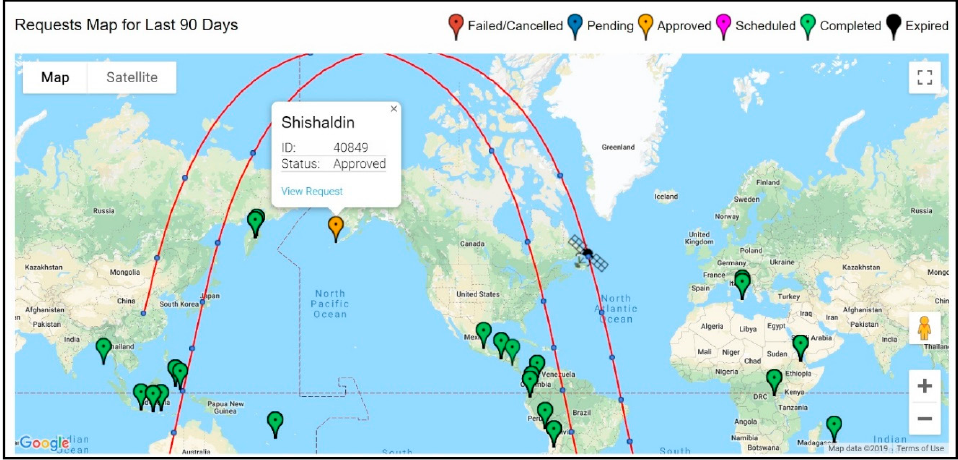
Figure 3. The ASTER Urgent Request Protocol (URP) Program scheduling interface using Google Maps, and maintained at the LP DAAC. All currently monitored URP target volcanoes are shown with a color-coded pin. These are updated automatically when new targets are triggered or existing ones have a change of status. Each pin is clickable to display more information and links to other metadata. The position of the Terra spacecraft and its orbit tracks are also